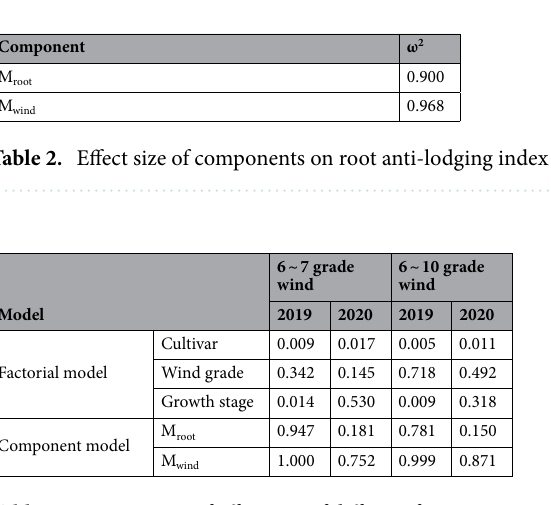
Table 3. Comparison of effect size of different factors on root anti-lodging